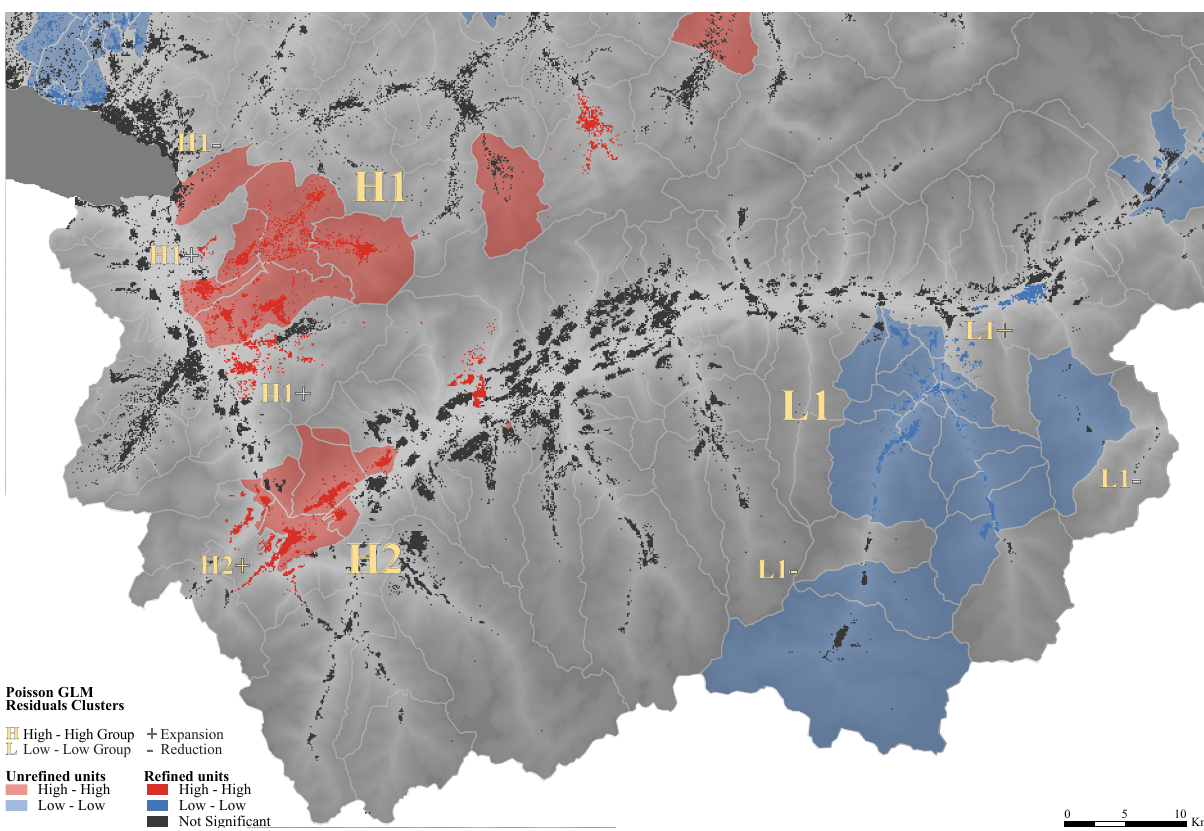
Figure 4. High-high and low-low model residual clusters for unrefined municipality units and dasymetrically refined units (data: SFOT,